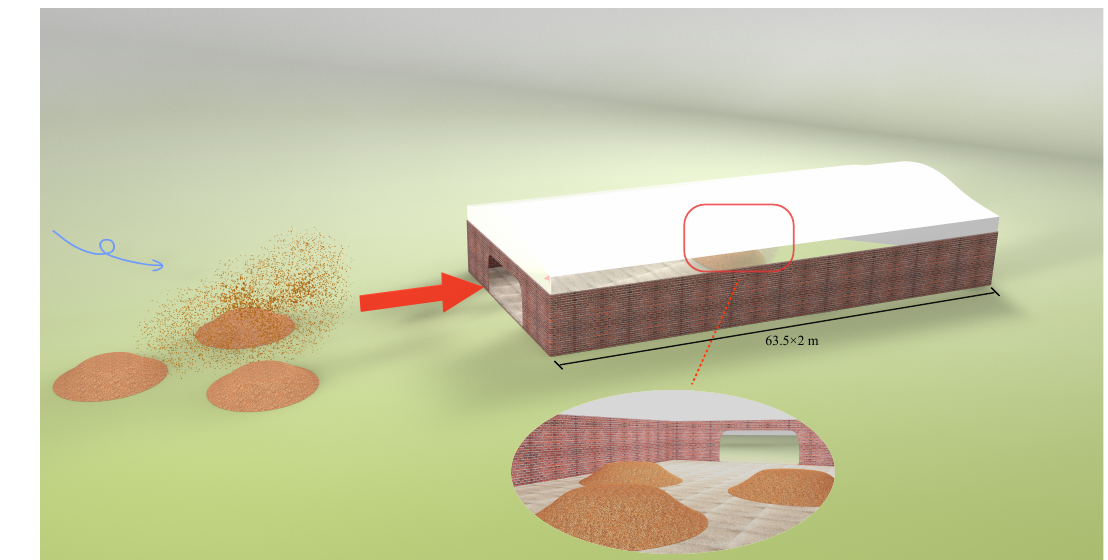
Figure 12. Illustration of the yard